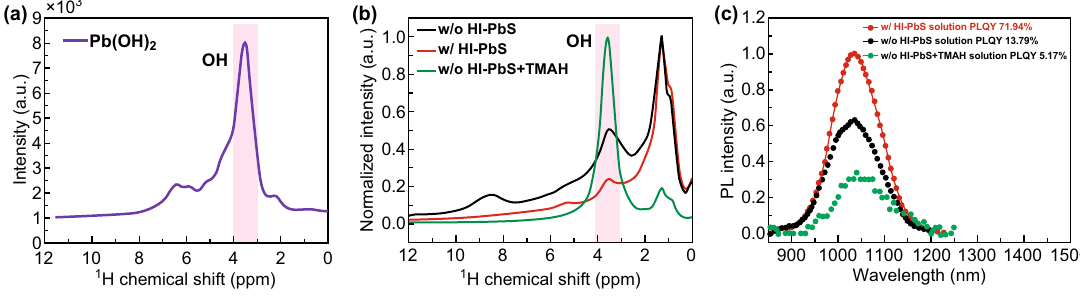
Fig. 2 a 1 H NMR for Pb(OH) 2 powders, b 1 H NMR for w/o, w/HI‑PbS, and HI‑PbS + TMAH powders. c Relative PL intensity of w/o,